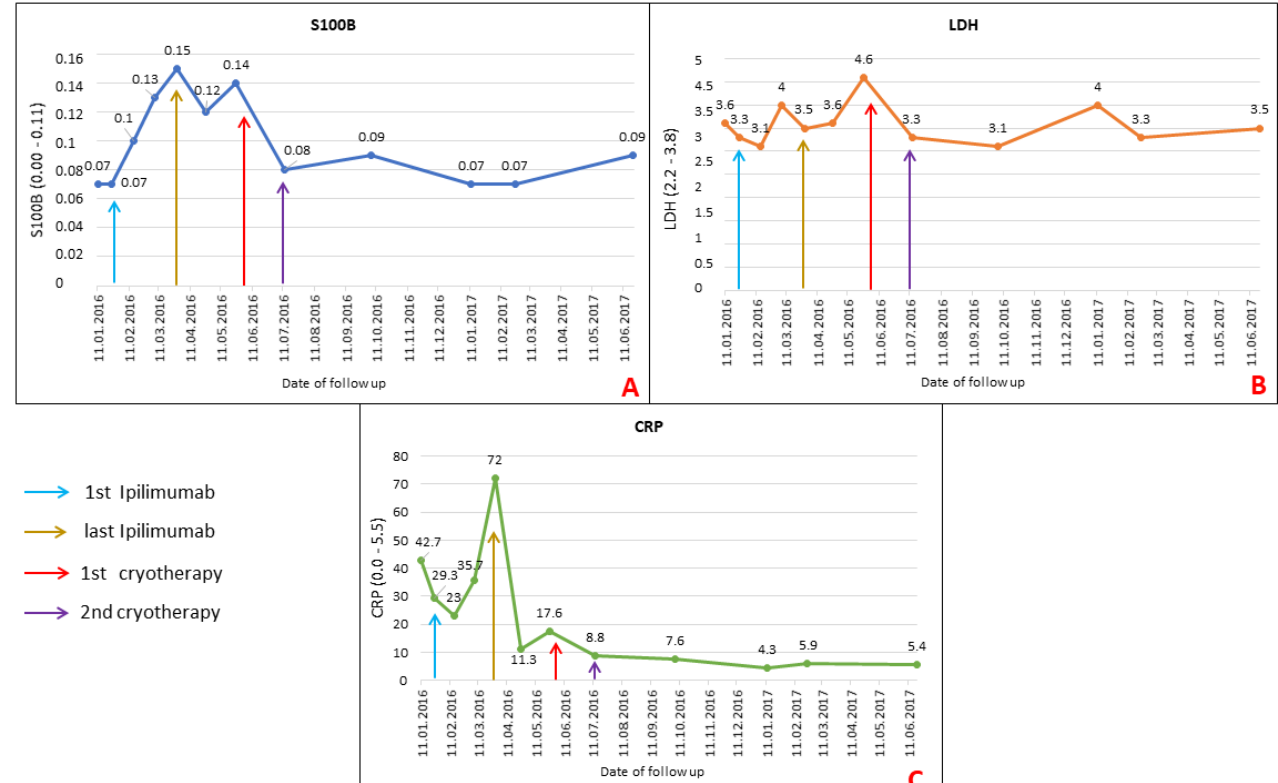
Figure 6. This figure shows the serological analysis of S100B, LDH and CRP during the patient’s follow up. Graph A shows